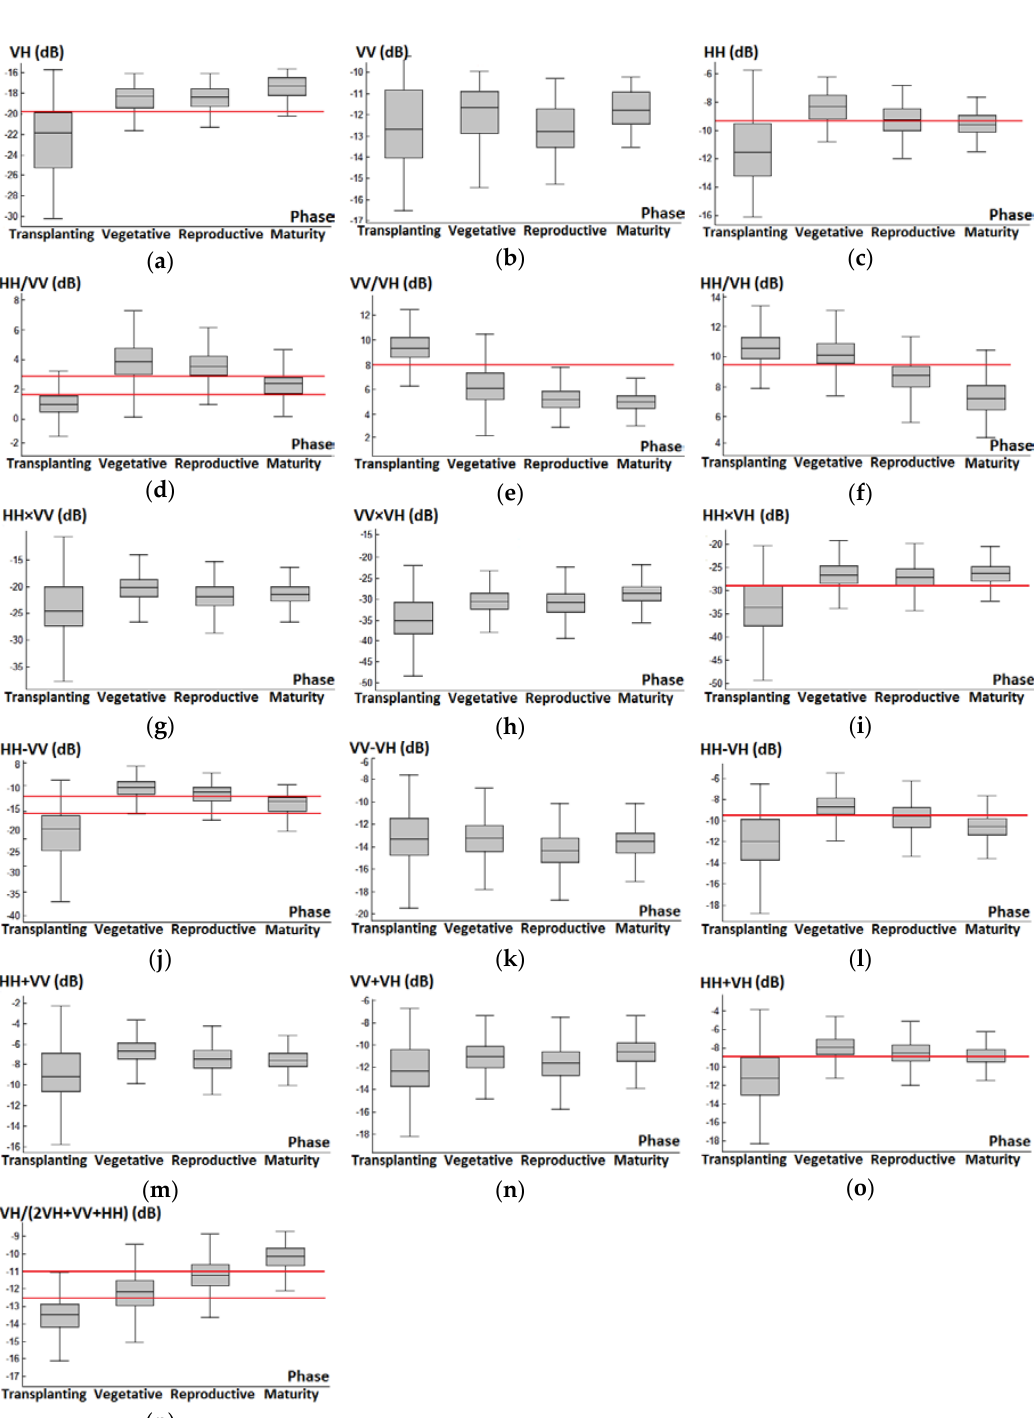
Figure 7. Boxplots of backscattering coefficients (training dataset, expressed in logarithmic scale) and their combinations (calculated in linear scale then expressed in logarithmic scale) at each phase, ( a ) VH, ( b ) VV, ( c ) HH, ( d )HH/VV, ( e ) VV/VH, ( f ) HH/VH, ( g ) HH × VV, ( h ) VV × VH, ( i ) HH × VH, ( j ) HH − VV, ( k ) VV − VH, ( l ) HH − VH, ( m ) HH + VV, ( n ) VV + VH, ( o ) HH + VH, ( p ) VH/(2VH + VV + HH). Red lines represent possible division values to separate at least two interquartile ranges (grey part of boxes).